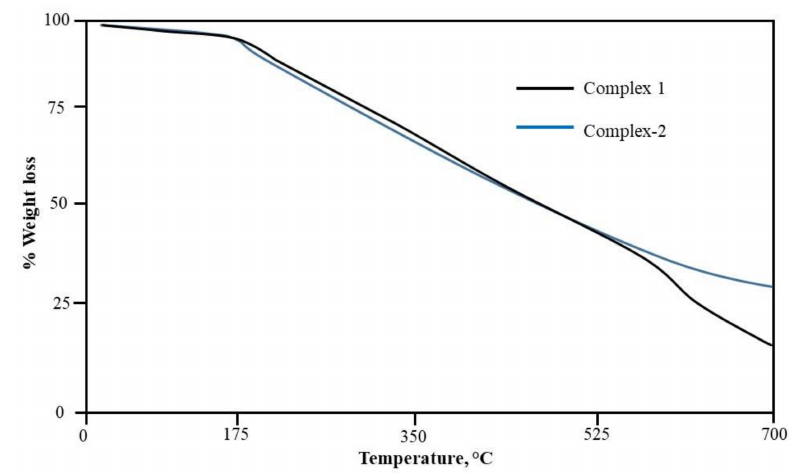
Figure 7. TGA curve of complexes 1 and 2.